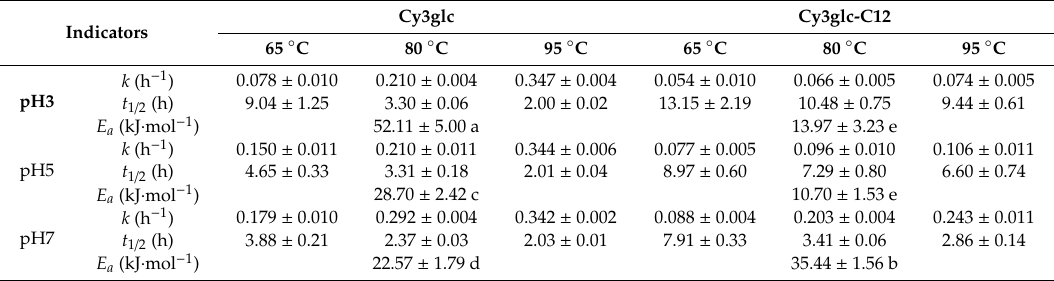
Table 2. Kinetic parameters determined from the thermal-degradation assays of Cy3glc and Cy3glc-C12 in an aqueous SDS solution.